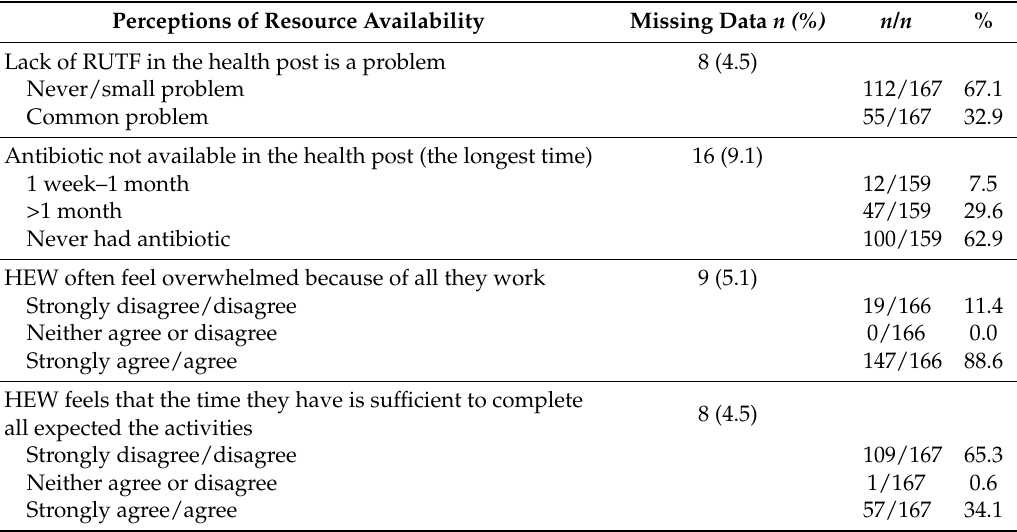
Table 1. Health extension workers’ perceptions of resource availability at their health posts ( n =